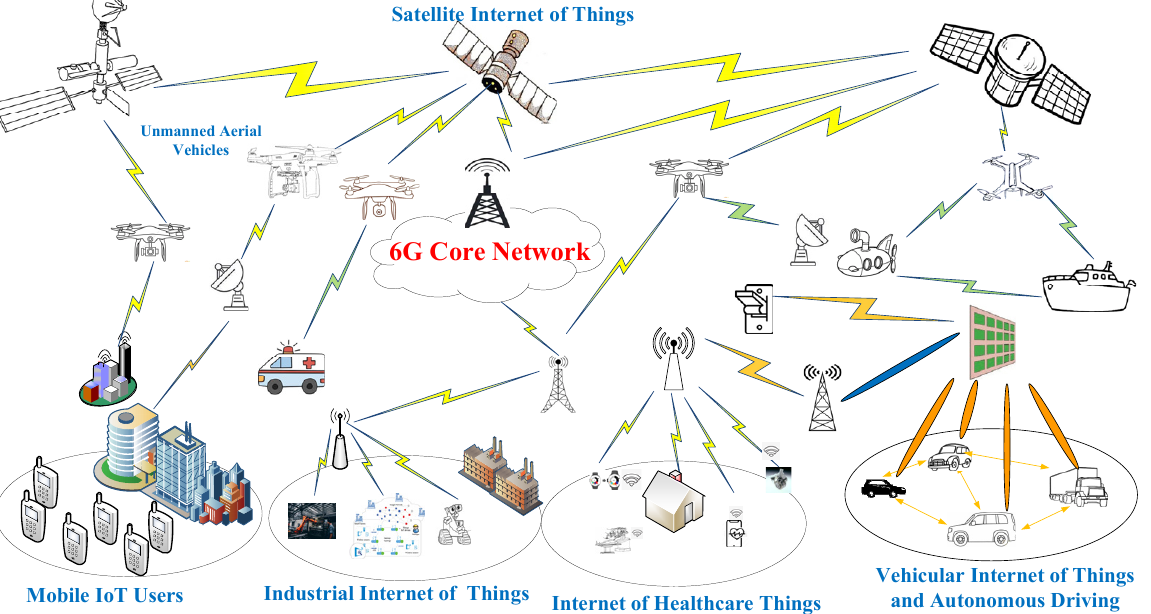
Figure 1. A panorama of the 6G IoT network.